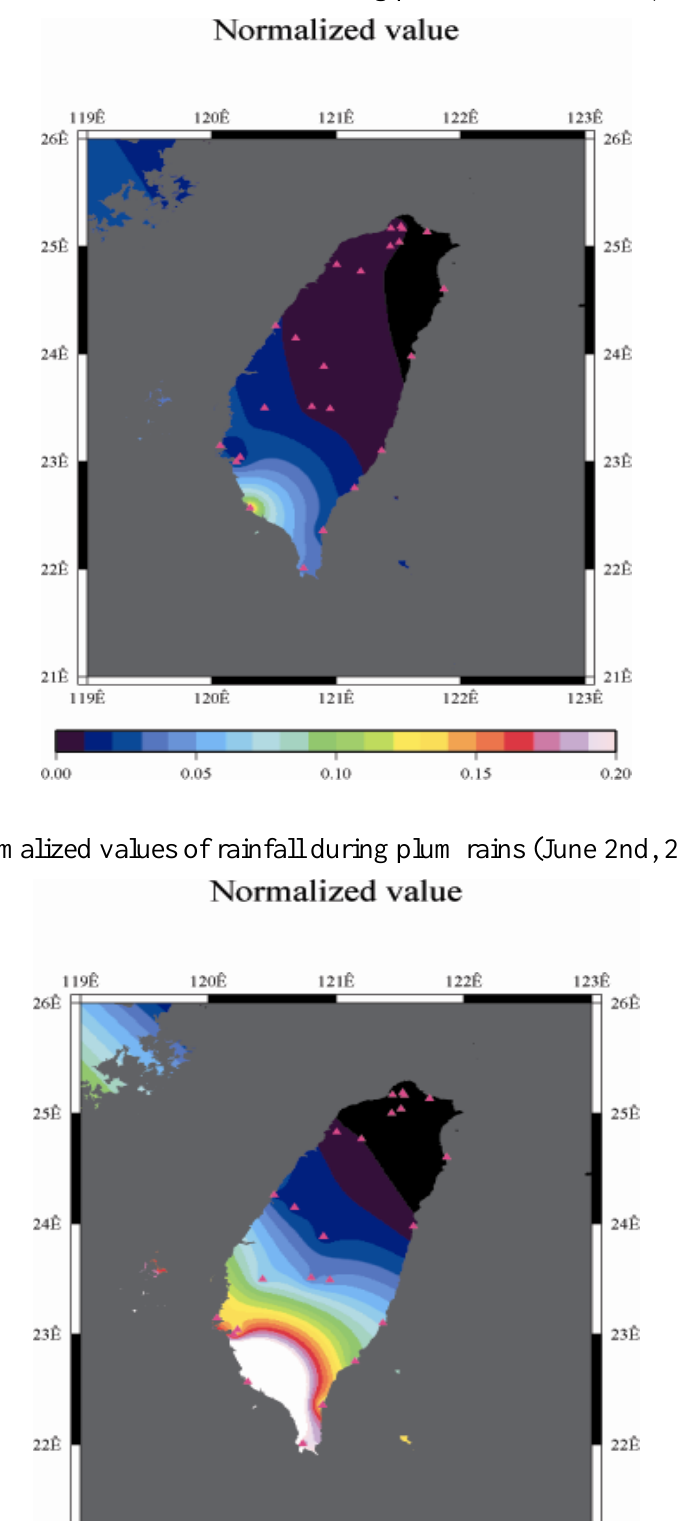
Figure 22. Normalized values of rainfall during plum rains (June 2nd, 2008, 1:00 PM).